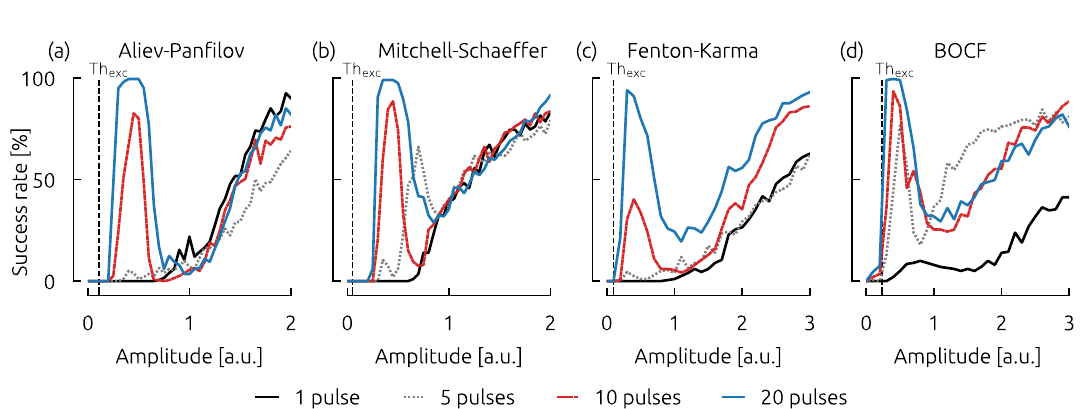
Figure 4. Dose-Response curves for selected pacing frequencies (( a ) AP: 1.3 f dom , ( b ) MS: 1.1 f dom , ( c ) FK: 1.1 f dom , ( d ) BOCF: 1.04 f dom ). The success rates of the selected pacing frequencies are marked as horizontal gray dashed lines in Fig.